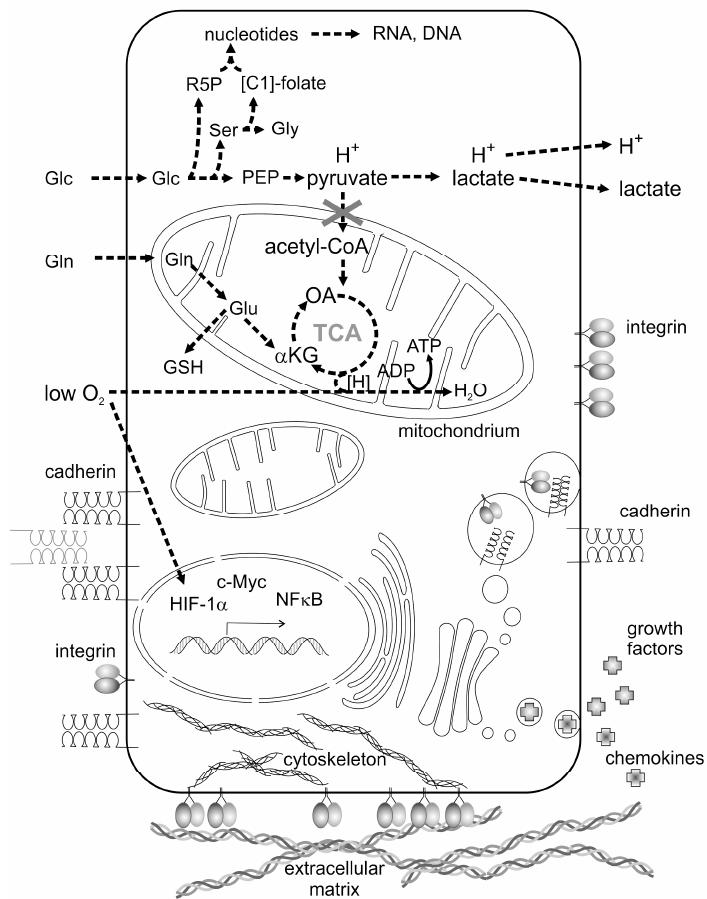
Figure 1. Metabolic reprogramming and an altered intercellular communication are hallmarks of cancer cells. Enhanced demands of glucose (Glc) and glutamine (Gln) as well as low supply of oxygen are characteristic features of cancer cell metabolism. They activate distinct transcription factors, such as hypoxia-inducible factor 1 α (HIF-1 α ), cellular Myelocytomatose (c-Myc) and nuclear factor κ -light-chain-enhancer of activated B cells (NF κ B), and upregulate expression of glycolytic and glutaminolytic key enzymes. Aerobic glycolysis leads to a high lactate concentration and a low pH of the tumor microenvironment (TME). Glycolytic metabolites stimulate the pentose phosphate pathway to produce ribose-5-phosphate (R5P) and the production of the amino acids serine (Ser) and glycine (Gly), thereby filling the tetrahydrofolate pool of C1-groups ([C1]-folate). The tricarboxylic acid (TCA) cycle is fueled by glutamine (Gln) via glutamate (Glu) and α -ketoglutarate ( α KG). Glutamate is also converted to glutathione (GSH), an intracellular redox buffer. Metabolites, phosphoenolpyruvate and oxaloacetate are abbreviated to PEP and OA, respectively. Membrane-bound cell adhesion molecules (e.g., integrins) and cell–cell contact molecules (e.g., cadherin), as well as secreted and soluble growth factors and chemokines are other key communicator molecules between cancer cells and their neighboring stromal cells. Cell adhesion molecules bind to the extracellular matrix (ECM) and sense its rigidity and mechanical forces.